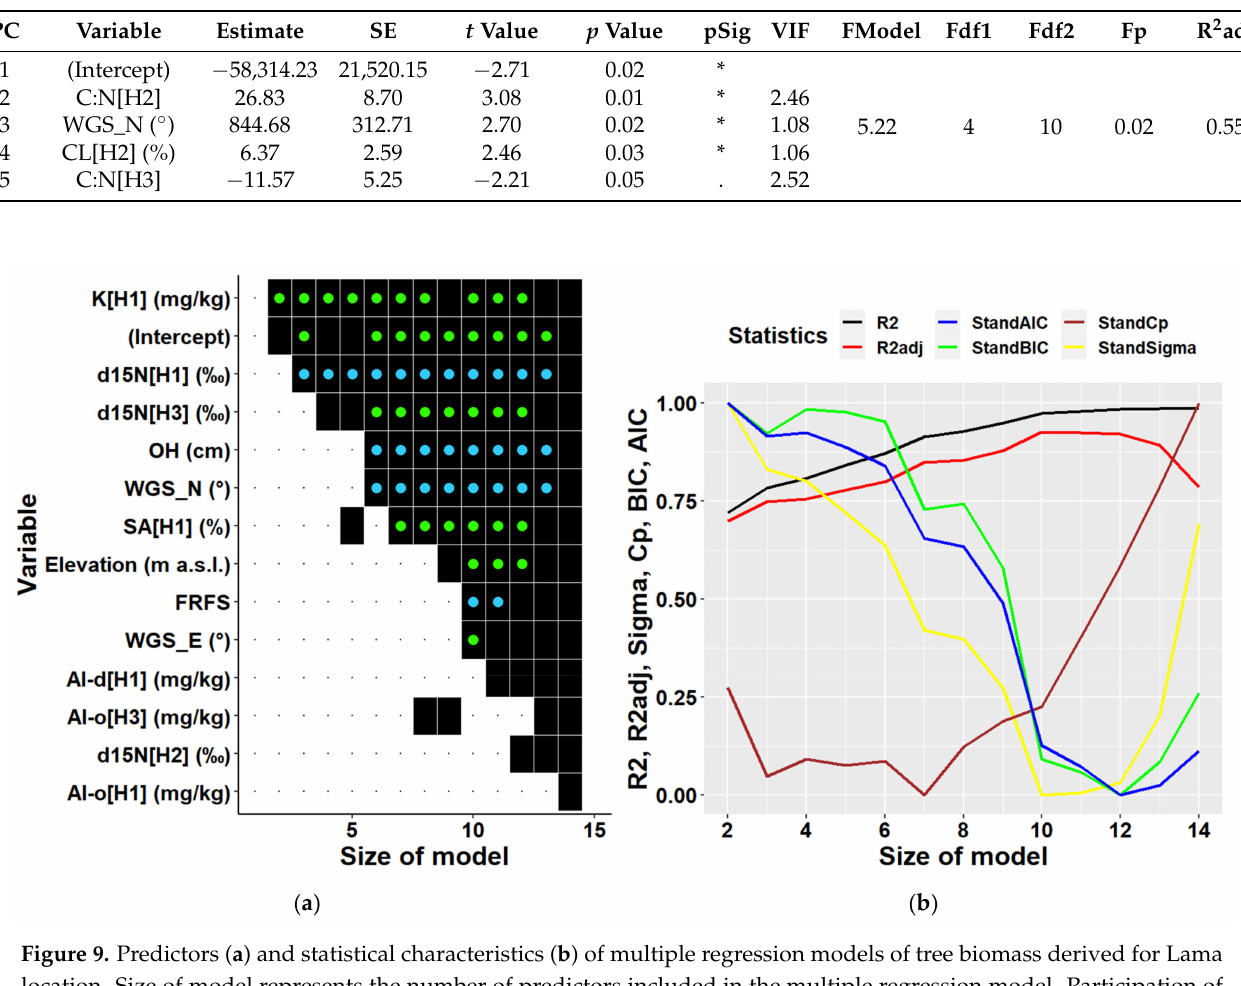
Table 4. Overview of variables included in the optimal multiple regression model (Biomass = f(Variable1, . . . , Variable5)) derived for Keta and their statistical characteristics (H1—soil layer 0–10 cm, H2—layer 10–20 cm, H3—layer 20–30 cm, C:N—C:N ratio, WGS_N ( ◦ )—latitude, CL (%)—clay fraction, Estimate—regression coefficient for the respective variable, SE—standard error, t value— t -value of Student test of coefficient, p value—probability of t value and its significance of